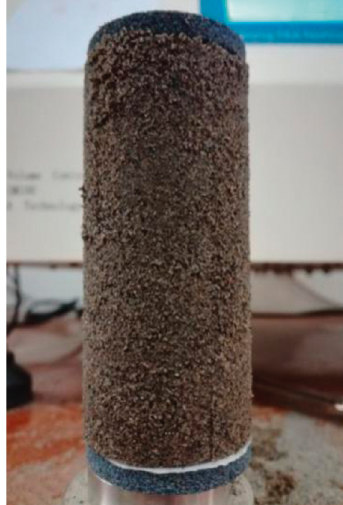
Figure 3: Sample of tailings sand after